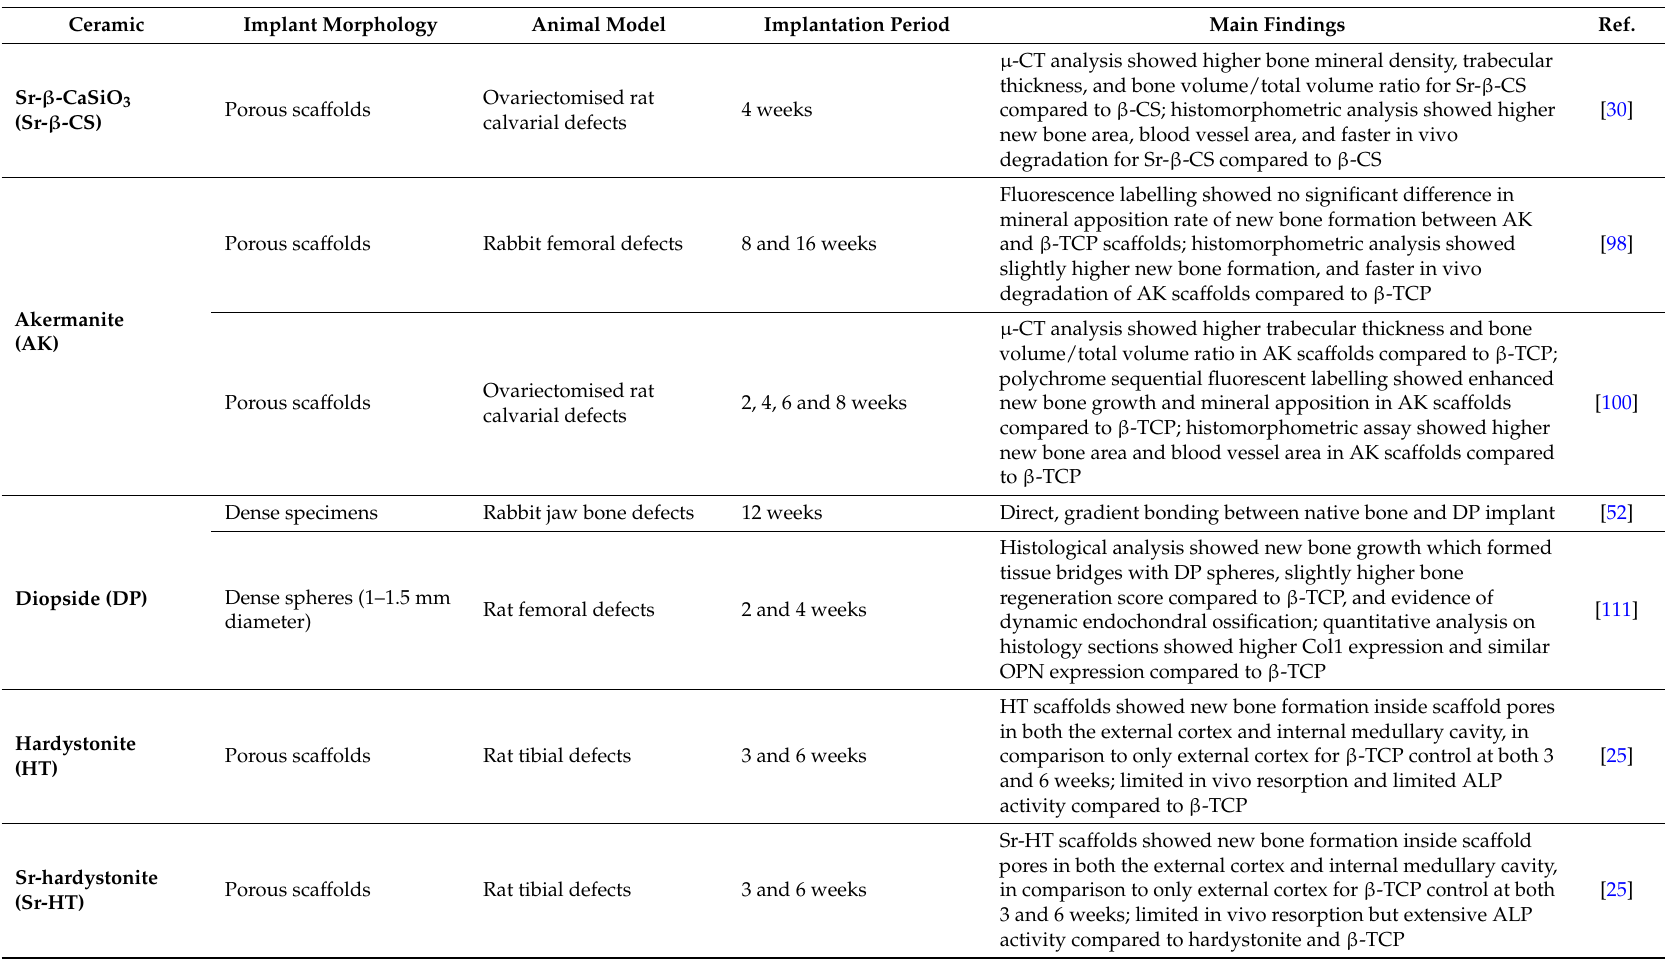
Table 6. Summary of in vivo studies on DCSCs performed in a range of animal models using dense specimens or porous